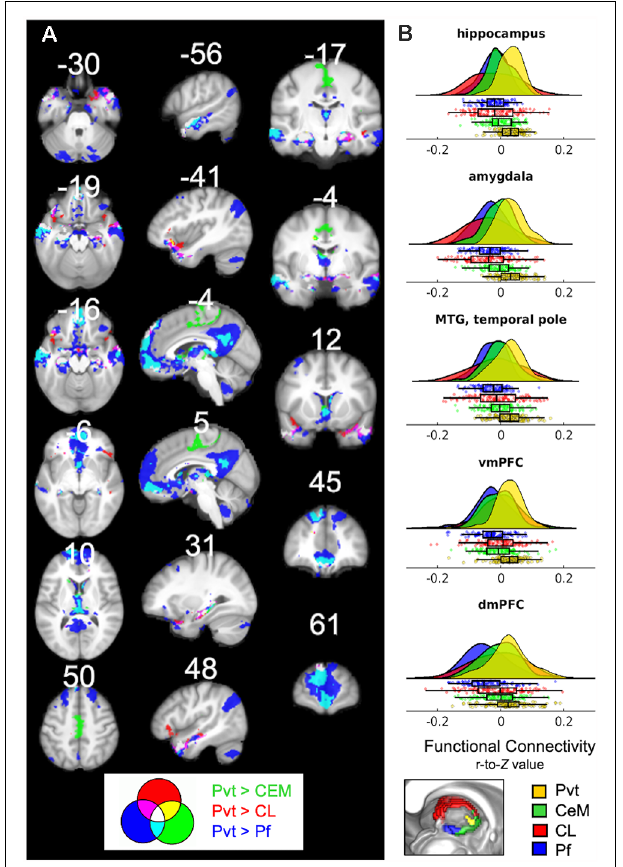
FIGURE 6 | (A) Regions that show positive PVT functional connectivity that is greater than functional connectivity of the CeM (green), CL (red), or Pf subnuclei (blue; e.g., PVT bivariate map (cid:84) PVT > CL semi-partial map both thresholded separately at p TFCE-FWE < 0.05). Some areas showed greater functional connectivity compared to CL and CeM (yellow), CeM and Pf (cyan), CL and Pf (violet), or all three (white). (B) Raincloud plots display density plots with the individual Fisher r -to- Z connectivity values for each participant extracted from regions that showed overlap between all three maps. Functional connectivity estimates from the separate ROIs are displayed in colors corresponding to the legend at the bottom. From top-to-bottom the subplots are displayed in descending order based on average effect size as calculated by paired Cohen’s d. Inset color mixing image (lower left) accessed from https://colourware.wordpress.com/ (colourmixing.gif, 2013). pole, and lateral areas. The 3T positive and negative FC maps are shown in Supplementary Figure 9 and their overlap with the 7T results in Supplementary Figure 10 . These results highlight the limitations of the PVT positive FC at 3T relative to 7T, but also emphasize the robustness of the major connectivity patterns across different magnet